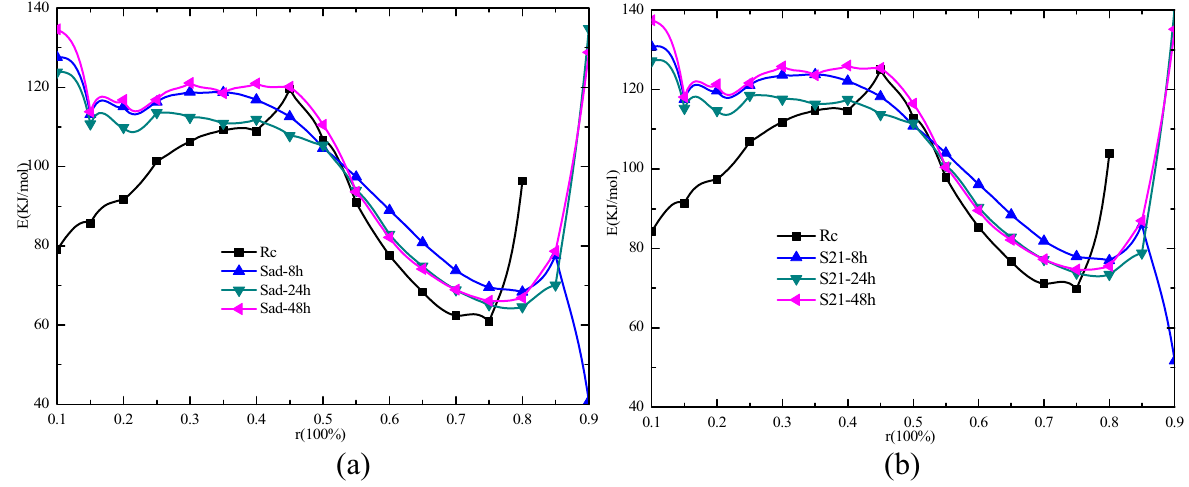
Figure 11. Activation energies (E) corresponding to different reaction rates solved by KAS and OFW methods (r = 0.1–0.9). ( a ) Activation energy (E) for the KAS method, ( b ) Activation energy (E) for the OFW